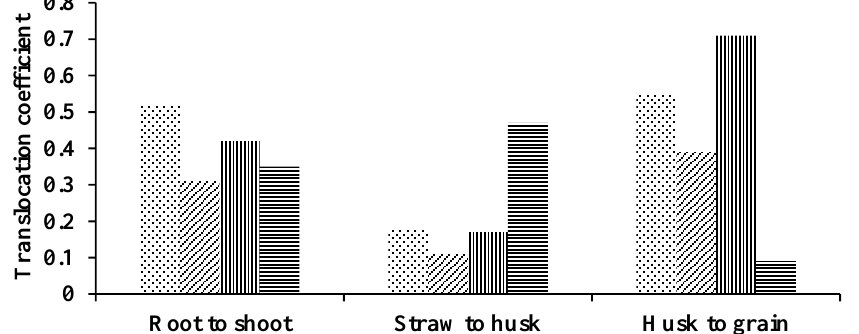
Figure 1. Translocation coefficients for the root to shoot, straw to husk, and husk to grain translocation of As in the different rice cultivars.